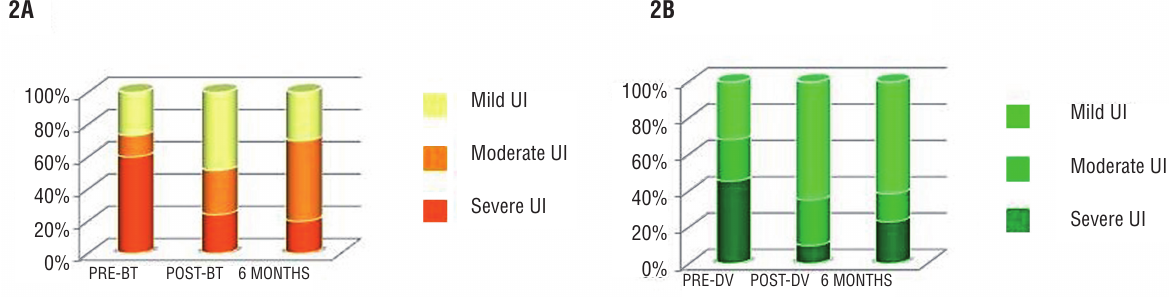
Table-3, the severity of complications, according to Clavien-Dindo classification, varies, with 2 pa- tients in the DV group (48%) requiring conversion to open surgery.